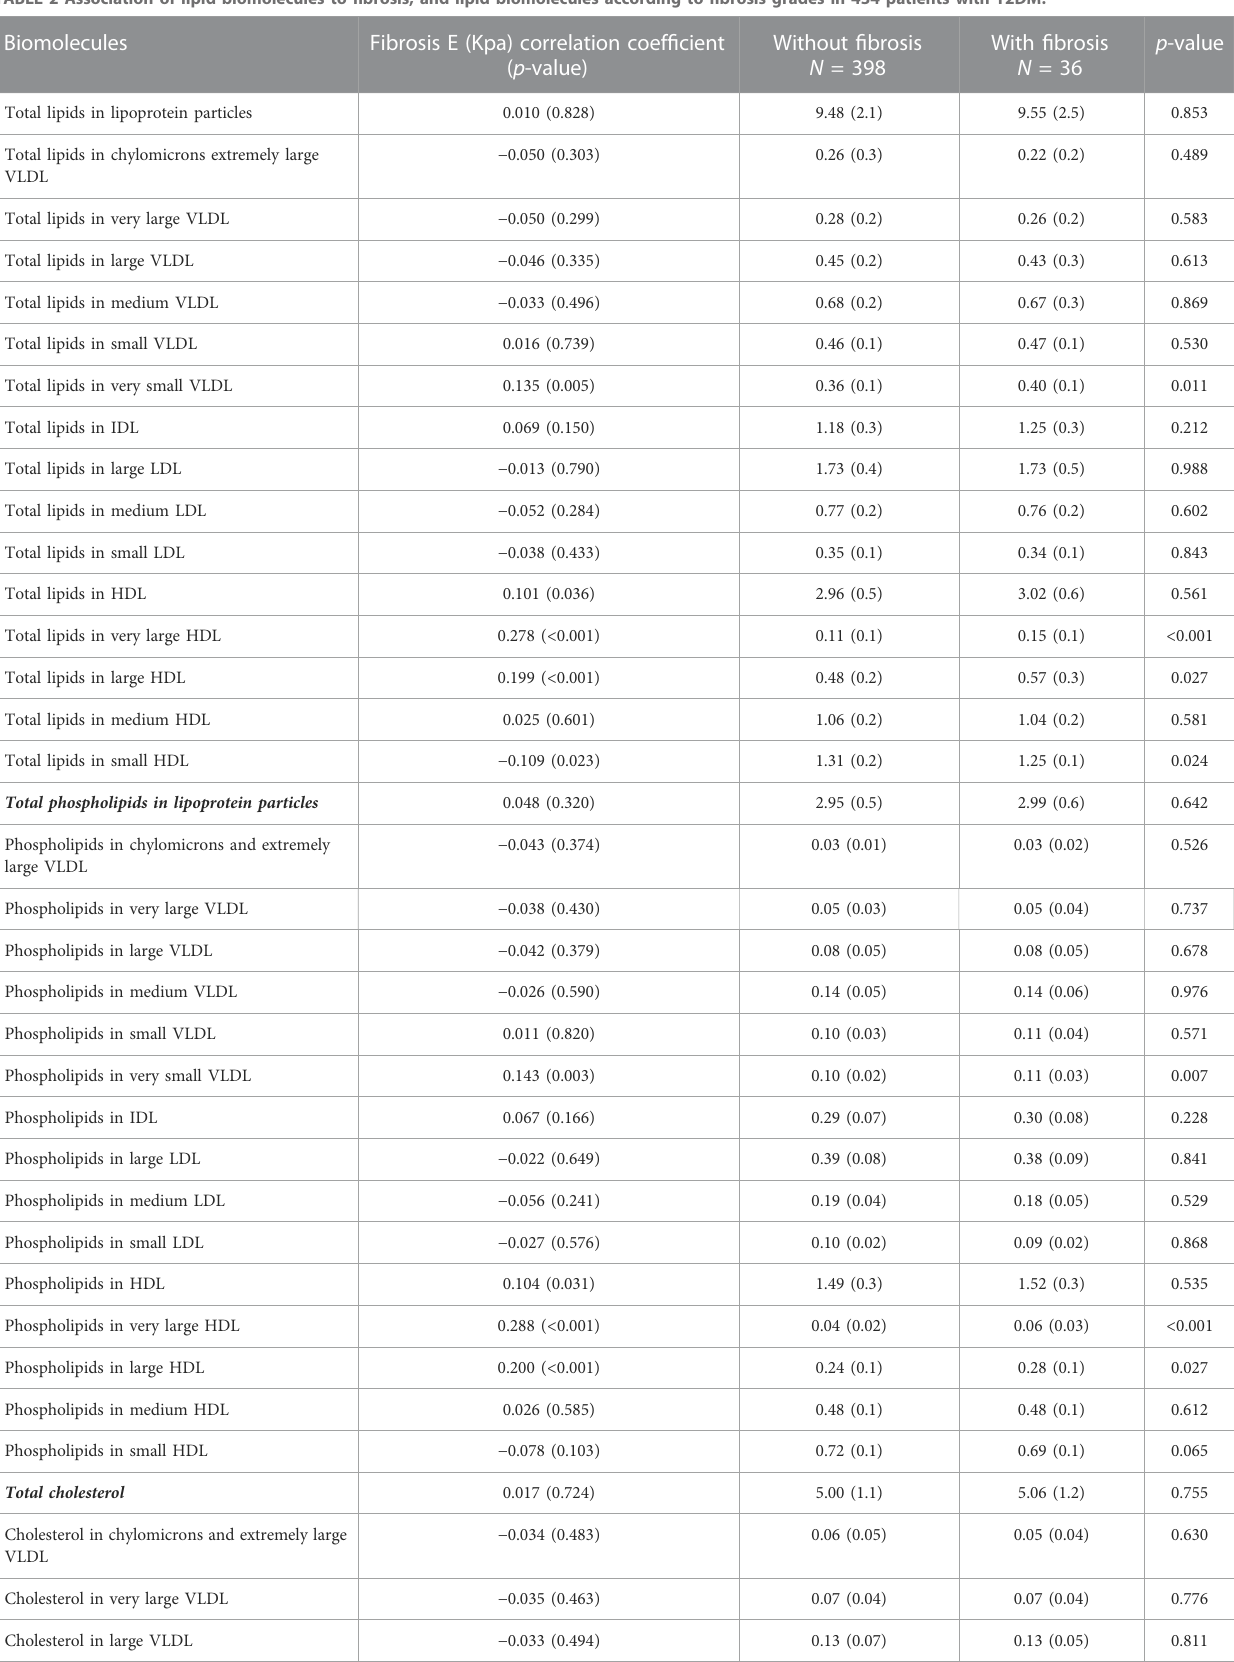
TABLE 2 Association of lipid biomolecules to fi brosis, and lipid biomolecules according to fi brosis grades in 434 patients with